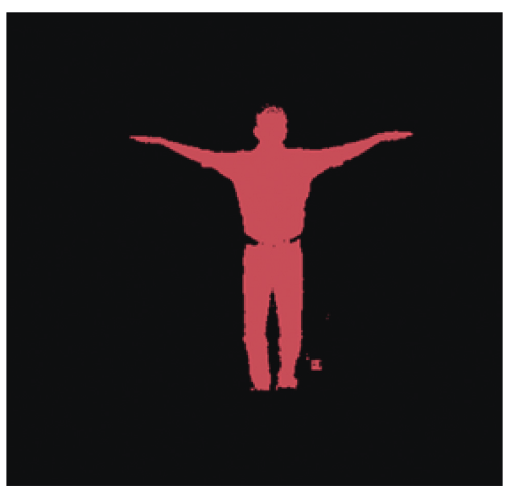
Figure 14: The person wearing a pure black color